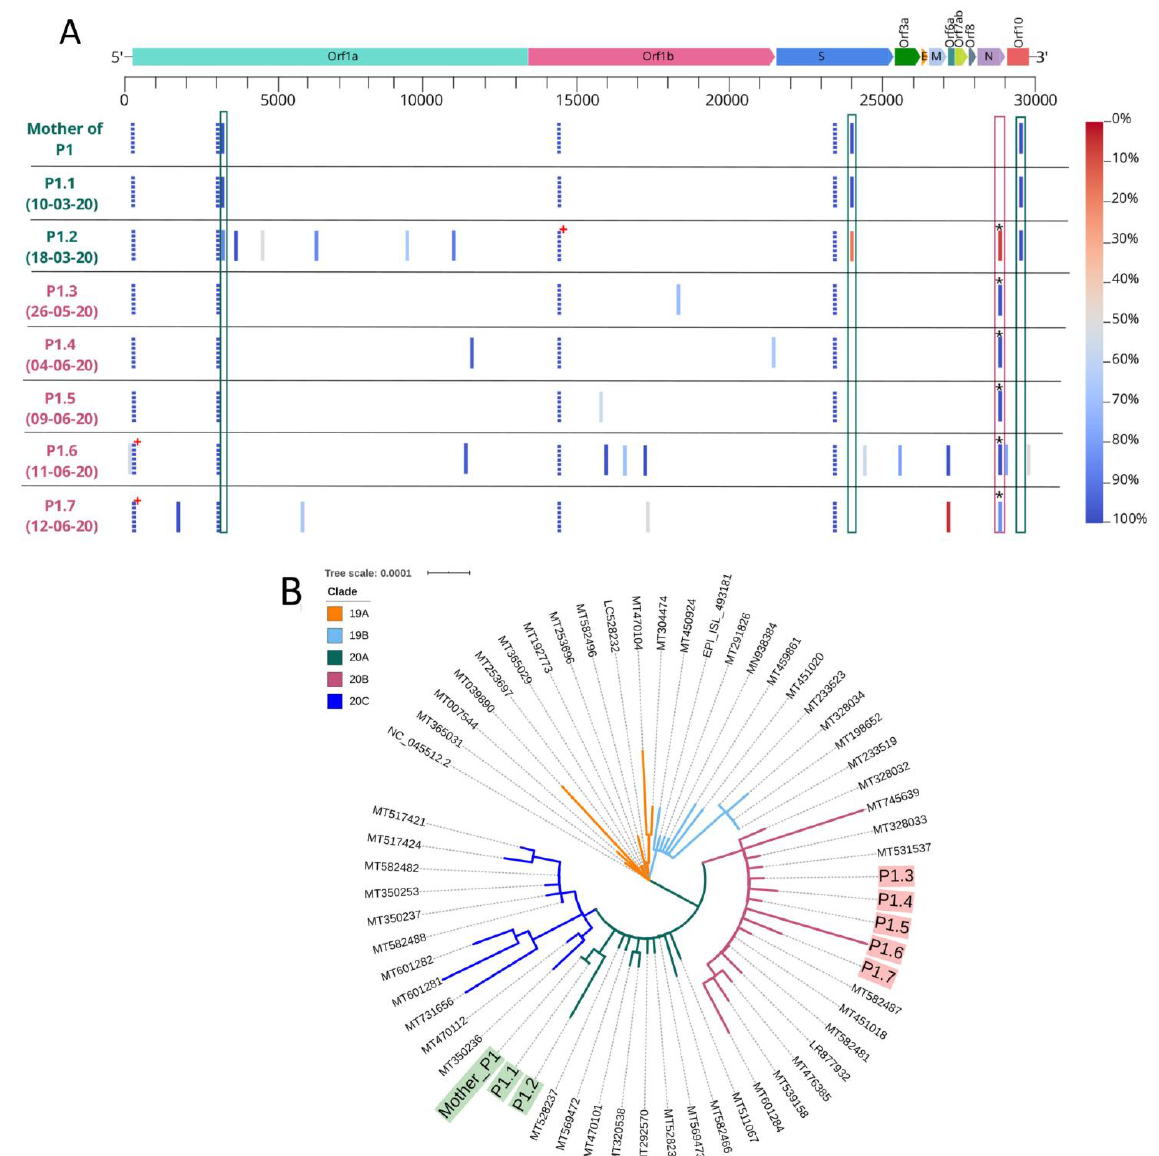
Figure 2. Detailed sequence diversity of the severe acute respiratory syndrome coronavirus 2 (SARS-CoV-2) isolates from the various samples. ( A )—Representation of the SARS-CoV-2 genome (genes are indicated) and the variants (only those with 50% frequency in at least one of the eight samples) sequenced in the isolates from the patient serial samples (P1.1 to P1.7) and her mother’s diagnostic sample. Date of sample collections are indicated below the patient samples ID, and the color code reflects the main 20A (in green) or 20B (in pink) SARS-CoV-2 lineage. The gradient bar indicates the frequency of the variants. For easier visualization, the shared variants between 20A and 20B lineages are indicated in doted bars. The boxes highlight either the specific 20A variants (in green) or the 20B-defining variants (in pink; the asterisk calls the attention to the three sequential variants, G28881A-G28882A-G28883C). The red cross indicates missing positions, matching known regions of the SARS-CoV-2 genome that are difficult to sequence. ( B )—Phylogenetic tree of the main SARS-CoV-2 clades known so far (19A, 19B, 20A, 20B, and 20C) and the sequences reported here (following the color scheme of A).